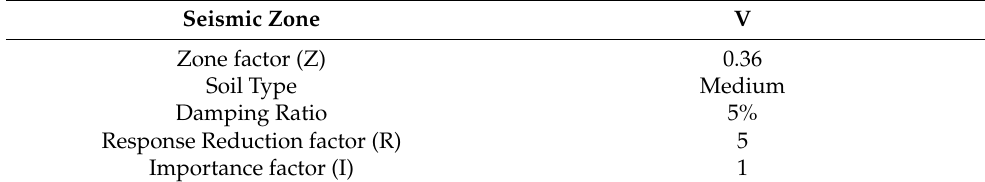
Table 3. Seismic data.